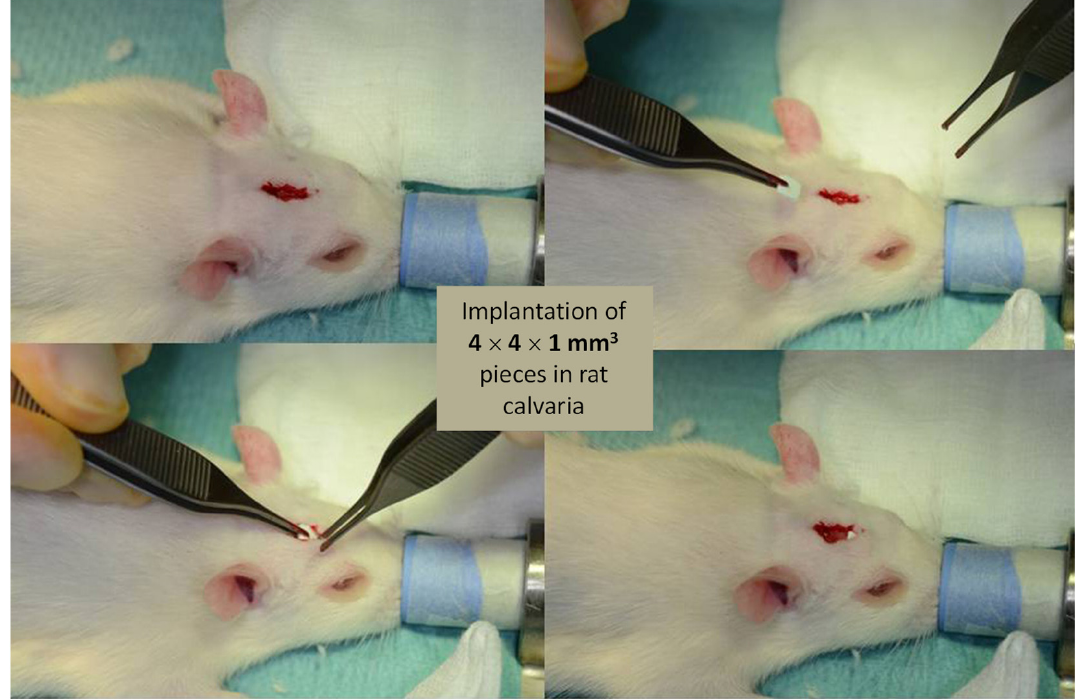
Figure 11. Implantation procedure on top of the rat’s calvarial bone.